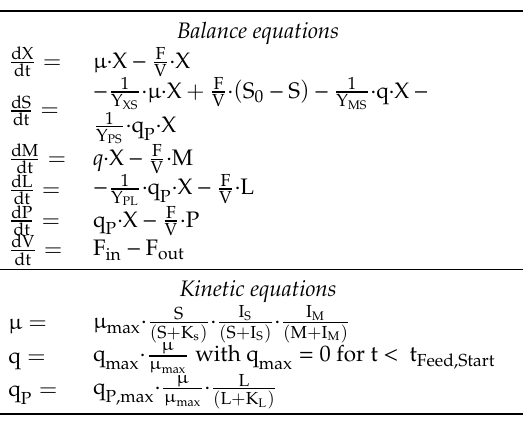
Table A19. Model equations for NMPC: Model D.